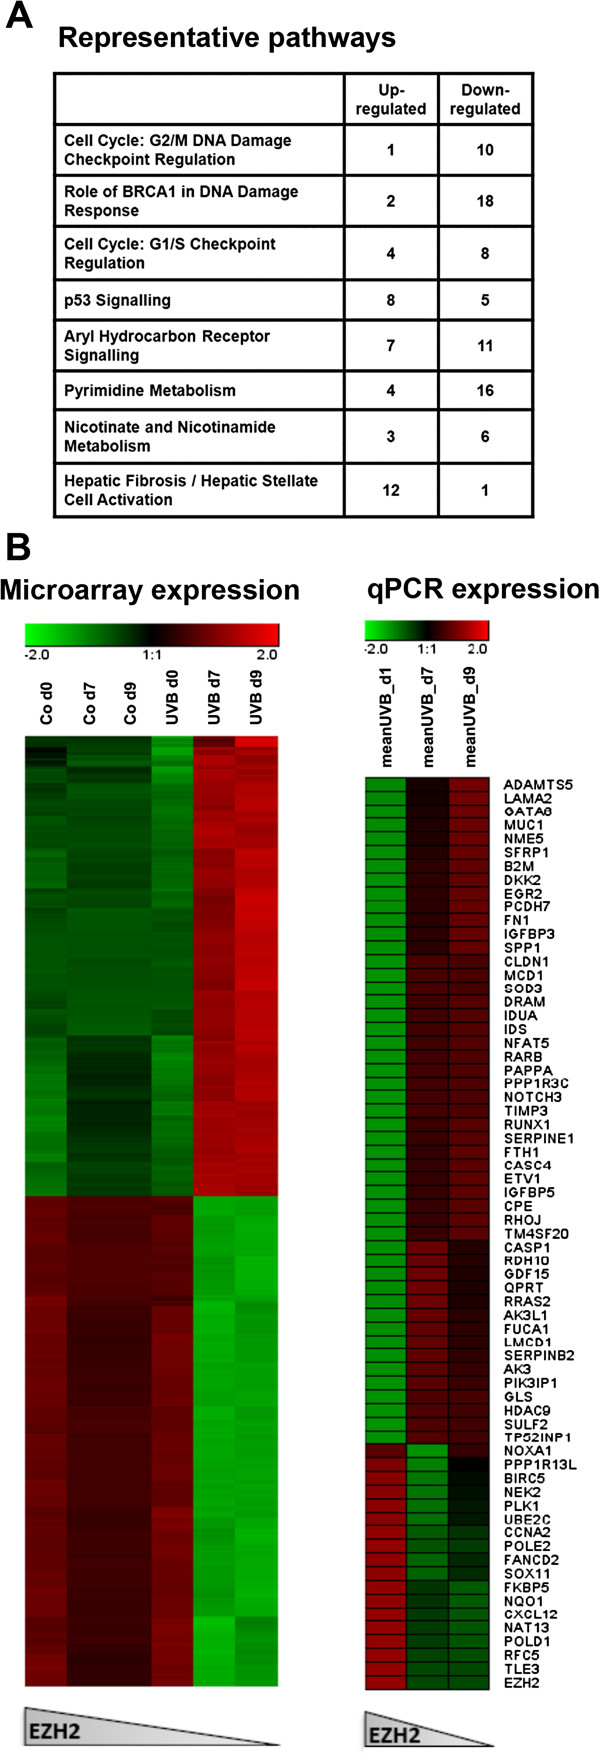
Transcriptome analysis of UVB-induced senescence. A. Ingenuity pathway analysis. Activated pathways were determined by Ingenuity System Pathway Analysis software (http://www.ingenuity.com/) by Core Analysis. Shown are eight significantly activated pathways (threshold p-value ≤ 0.05). B. In silico analysis of mRNA expression change in response to UVB irradiation. (left) The differential gene expression profile from total RNA was examined by Affymetrix GeneChip analysis (cutoff of > 1.5 fold regulation) 1, 7, and 9 days between control and UVB irradiated of HDF samples. The expression values were sorted by level of Ezh2 expression (rows). (right) Heatmap of selected 67 genes were determined by RT-PCR and sorted by level of Ezh2 expression (rows), red representing overexpression and green representing underexpression of the transcript.